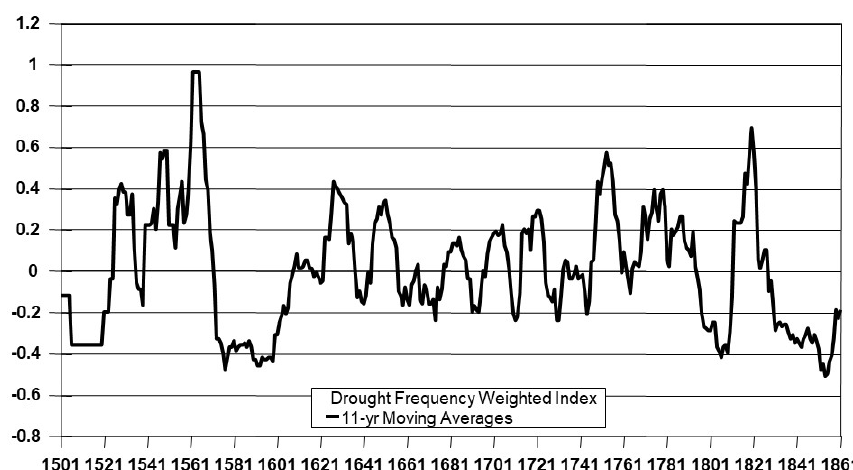
Figure 1. Drought frequency weighted index (1501–1861). Standardised values. Eleven-year moving averages from four cities: Girona, Barcelona, Tarragona and Tortosa. Data adapted from Oliva et al. (2018).